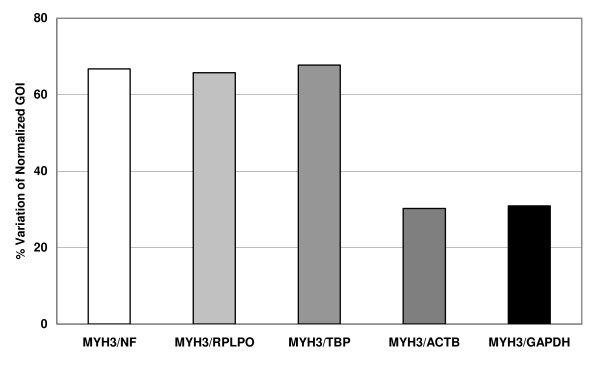
Percent variation of gene of interest (GOI) expression. Percent variation in the expression of MYH3 gene between myoblasts treated with medium N and medium D after 12 days culture. The MYH3 expression was normalized with the NF, the best RG (RPLPO and TBP) and the worst RG (ACTB and GAPDH) candidates. Representative results from at least three experiments.